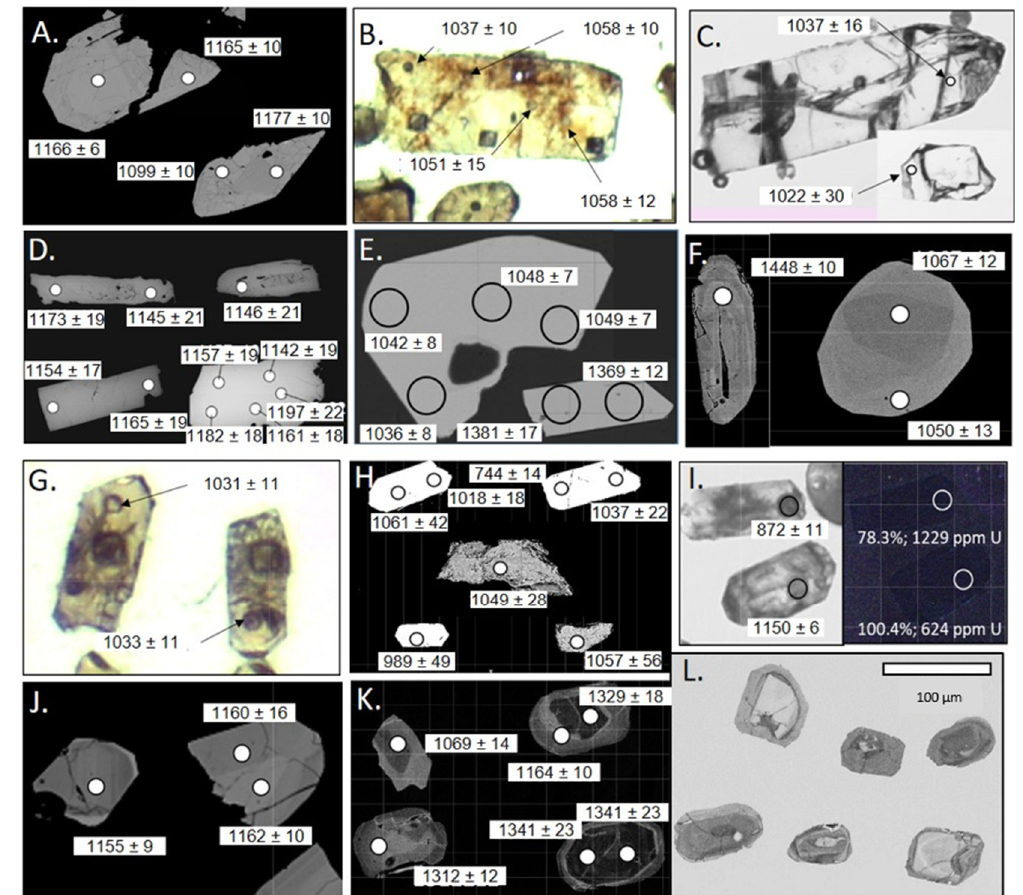
Figure 4. Representative photomicrographs and scanning electron microscope images of the zircon crystals analyzed during this study. All circular ablation pits were 30 µ m in diameter; ages are given with an uncertainty in Ma. ( A ) Hickory Lake locality. Note the younger age in the outer rim of the grain in the SE corner, BSE. ( B ) Fine locality. Large zircon analyzed several times, polarized light. ( C ) Keene Airport. Representative crystals, Note the large size and euhedral shape, polarized light. ( D ) Natural Bridge locality. Note the elongate grains, each with a fractured core (upper two grains), BSE. ( E ) Rose Road locality. Note the di ff erences in size, shape, and age, BSE. ( F ) Edwards locality. Note the distinct shapes and ages of the crystals, cathodoluminscence (CL). ( G ) Dana Hill locality. Note the dark coloration of the grains and circular U–Pb and square (trace-element) ablation pits, polarized light. ( H ) Jenne Farm locality. Note the di ff erence in shape and response of the crystals to BSE. ( I ) West Pierrepont locality. Left side: crystals in polarized light; right side: zircons in CL. Note the lack of CL response. ( J ) Powers Farm locality. Faceted, but near equant crystals, BSE. ( K ) Stone Valley locality. Note the di ff erences in CL signature and zircon core and rim regions. ( L ) Stone Valley locality. Note the core and rim relations in BSE (inverted). Bar for scale.